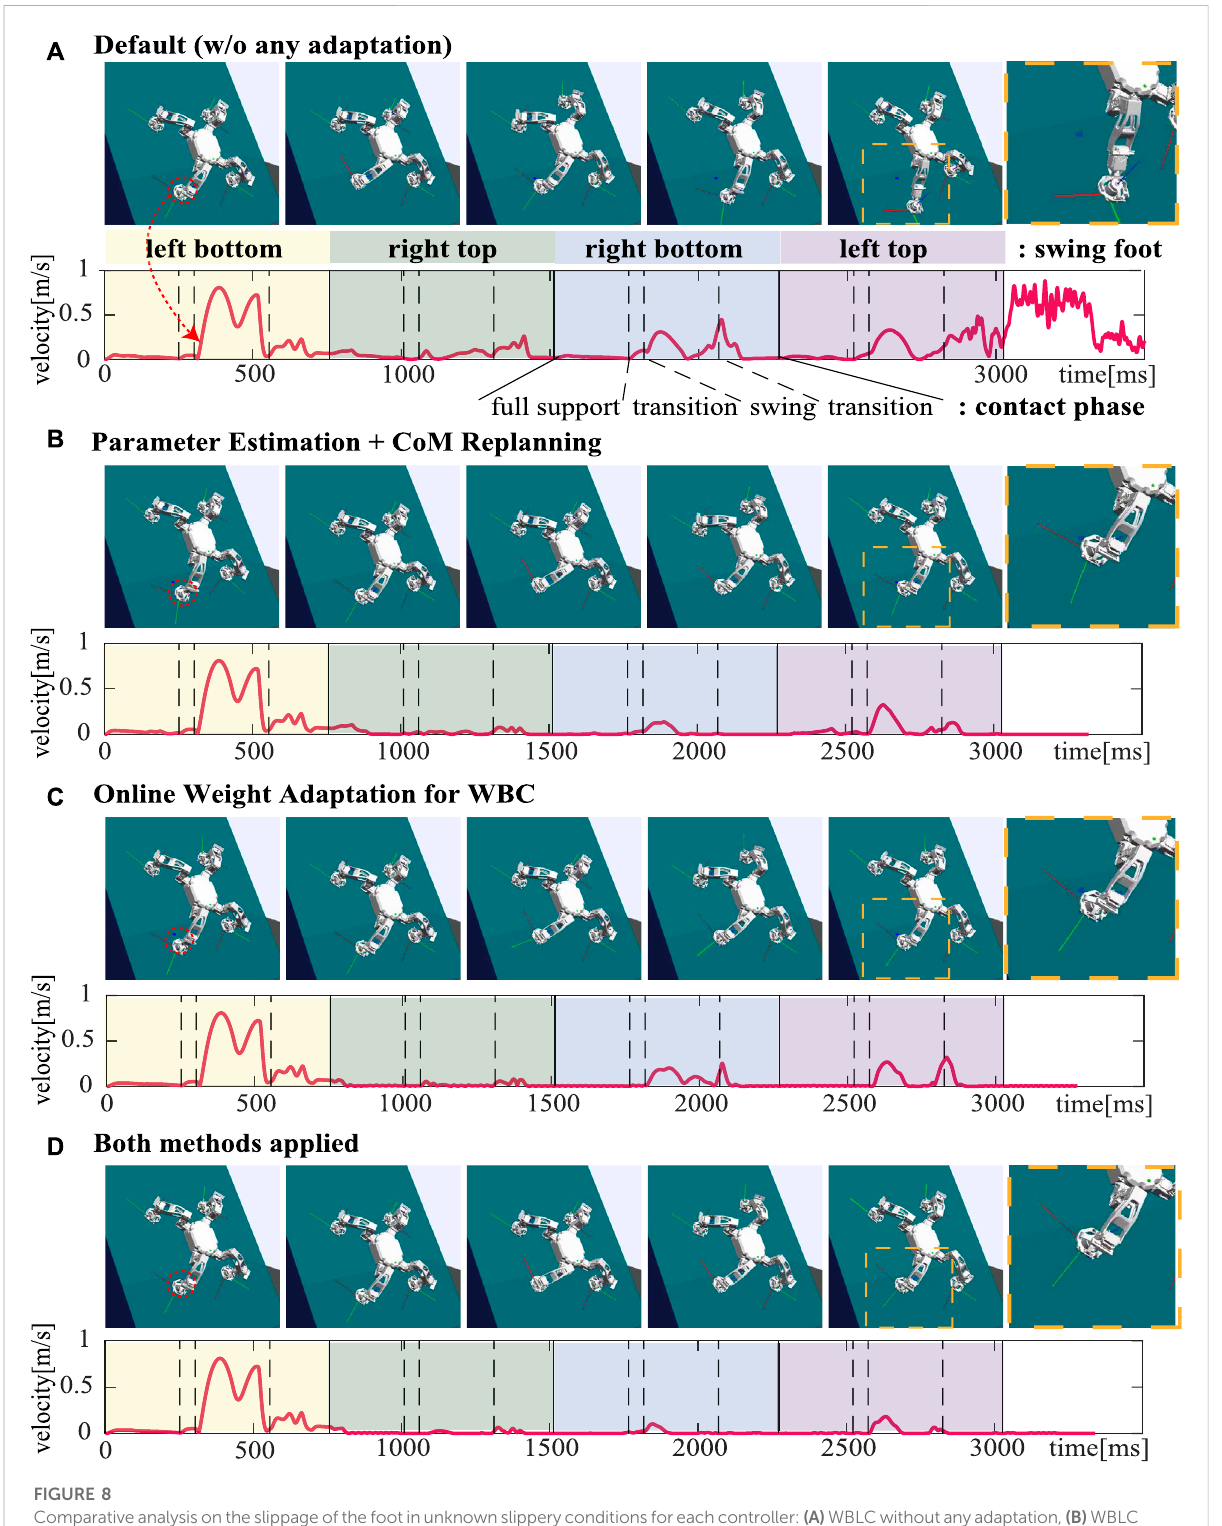
FIGURE 8 Comparativeanalysisontheslippageofthefootinunknownslipperyconditionsforeachcontroller: (A) WBLCwithoutanyadaptation, (B) WBLC with unknown parameter estimation and CoM replanning (described in Section 4), (C) WBLC with online weight adaptation (described in Section 5), and (D) WBLCwithbothmethods[applied in (B) and (C) ].Slipvelocitiesoftheleftbottomfootand snapshotsofthesimulationarerepresented.After the fi rst climbing step where the left bottom foot is used for swing, the velocity is supposed to be zero. Blue dots in the last zoom-in shots represent the desired foot